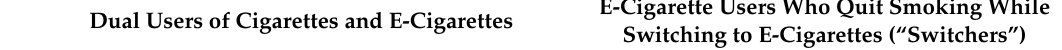
Table 1. E-Cigarette Flavor Use by Menthol Cigarette Smoking Status among US Adults (18+), 2018–2019 (% and 95% Confidence